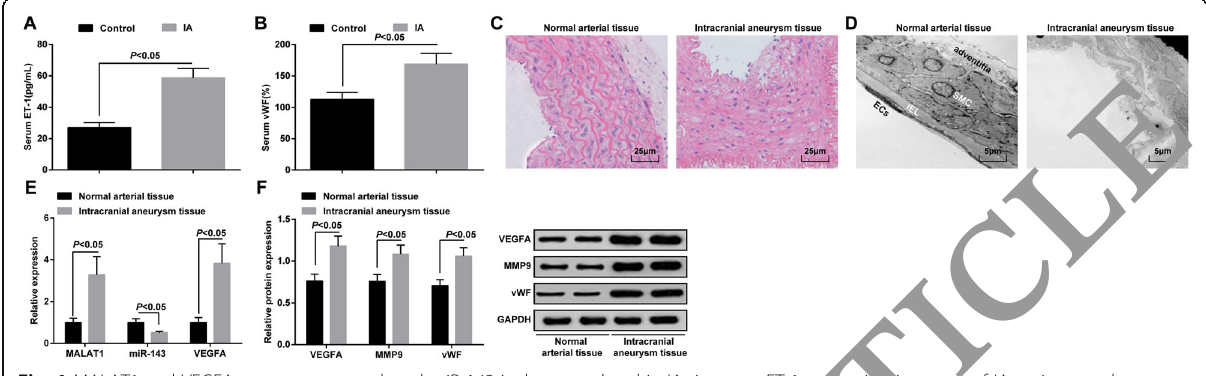
Fig. 1 MALAT1 and VEGFA are overexpressed, and miR-143 is downregulated in IA tissues. a ET-1 expression in serum of IA patients and temporal lobe epilepsy patients by ELISA. b vWF expression in serum of IA patients and temporal lobe epilepsy patients by ELISA. c Pathological observation of IA tissues and normal arterial tissues by HE staining. d Morphological observation of IA tissues and normal arterial tissues by a transmission electron microscope. e MALAT1, miR-143, and VEGFA mRNA expression in IA tissues and normal arterial tissues by RT-qPCR. f VEGFA, MMP-9, and vWF protein expression in IA tissues and normal arterial tissues by western blot analysis. Endothelial cells (ECs), internal elastic lamina (IEL), smooth muscle cells (SMC). Measurement data were depicted as mean ± standard deviation; comparisons between groups were conducted by independent sample t